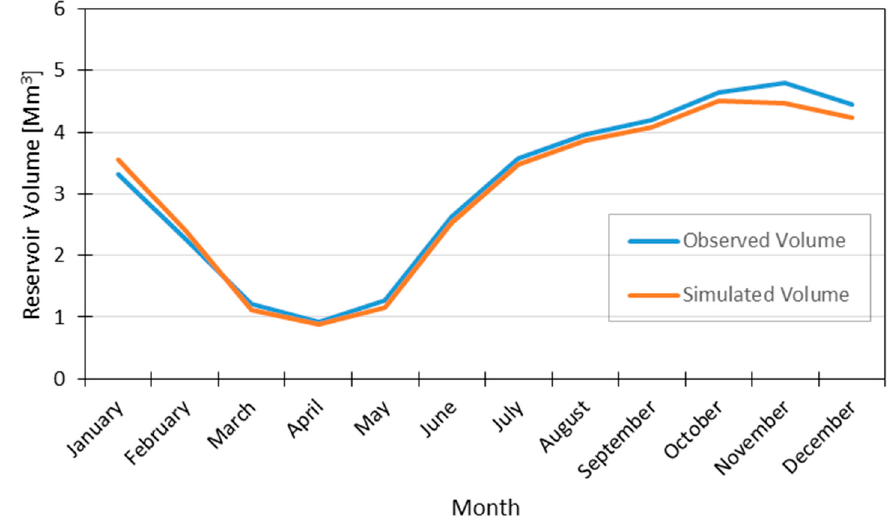
Figure 3. Comparison of the actual and simulated reservoir volumes for Tremorgio (1 January 2012 to 31 December 2012).